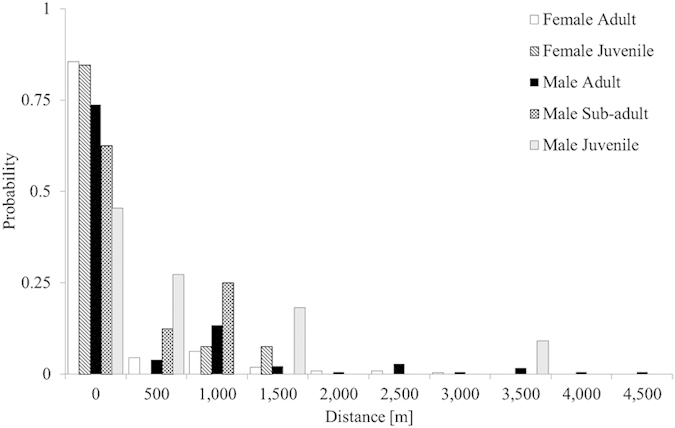
Distances moved by individual platypus, between the 15 surveyed pools (Fig. 1), in five age and sex classes: adult female (FA− white filled), juvenile female (FJ-diagonal lines), adult male (MA-black filled), sub-adult male (MSA− grey checker board), juvenile male (MJ− light shaded).